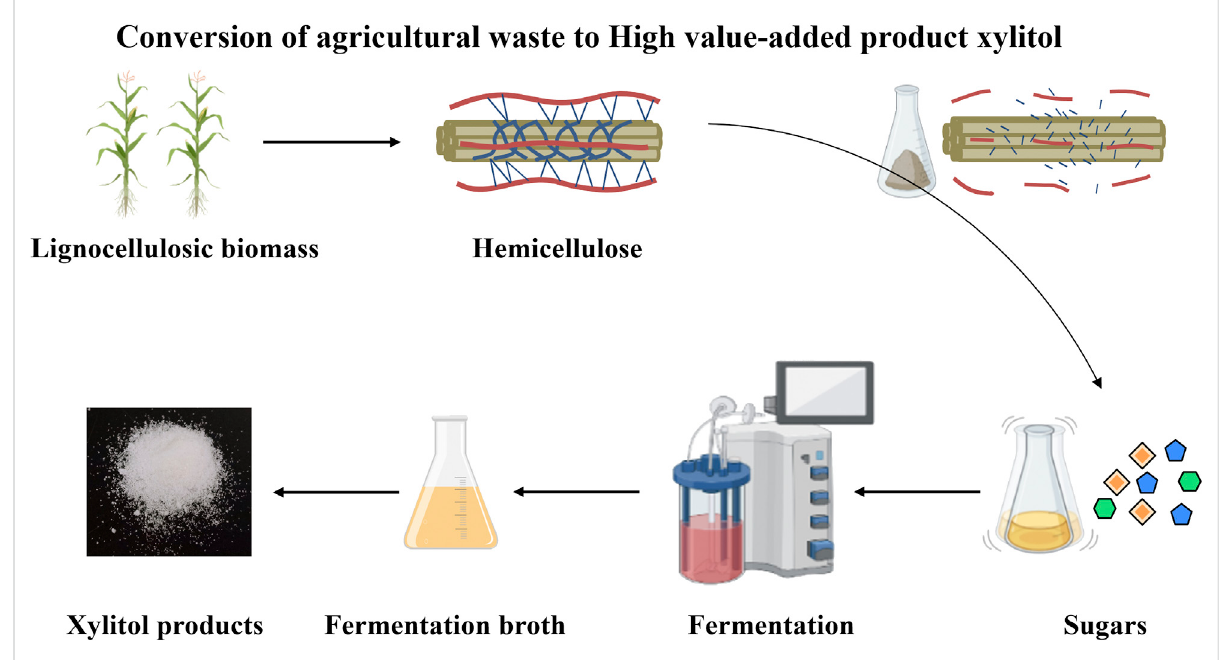
FIGURE 1 Systematic process from agricultural waste to high value-added product